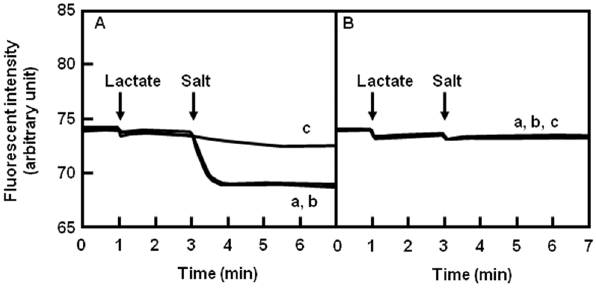
Figure 1. Effect of monovalent cations on energy-dependent DAPI efflux mediated by PdrM. Lactate-TMAH (final concentration 20 mM, pH 7.0) was added to the assay mixture (at the first arrow). At the time point indicated by the second arrow, either NaCl (curve a), LiCl (curve b), or KCl (curve c) was added to the assay mixture (final concentration 10 mM). (A) E. coli KAM32/pHAP5, (B) E. coli KAM32/ pHY300PLK (control). The fluorescence of free DAPI and DAPI binding with DNA was detected in the DAPI assay. However, the fluorescence from DAPI binding with DNA was stronger than free DAPI and the fluorescent intensity decreased when DAPI was pumped out of the cells.